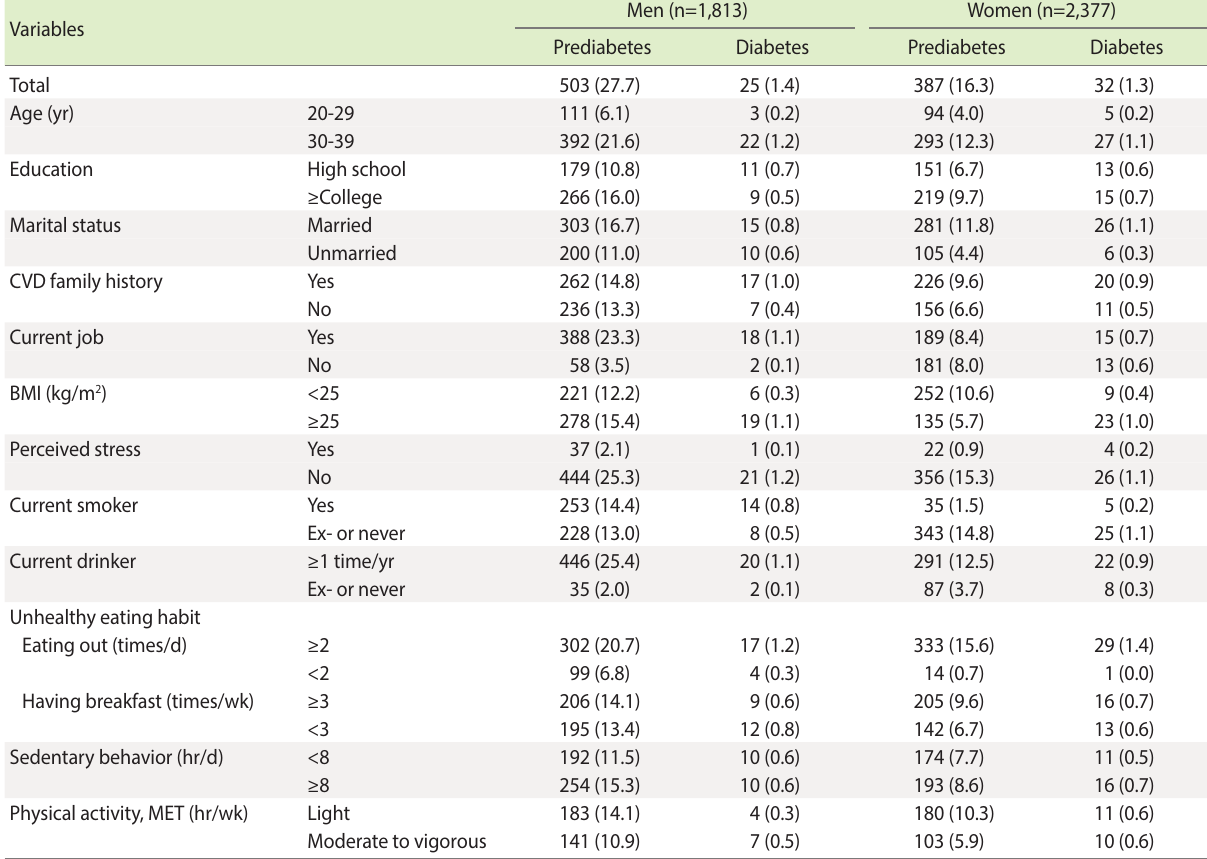
Table 2. Prevalence 1 of prediabetes and diabetes according to lifestyle variables